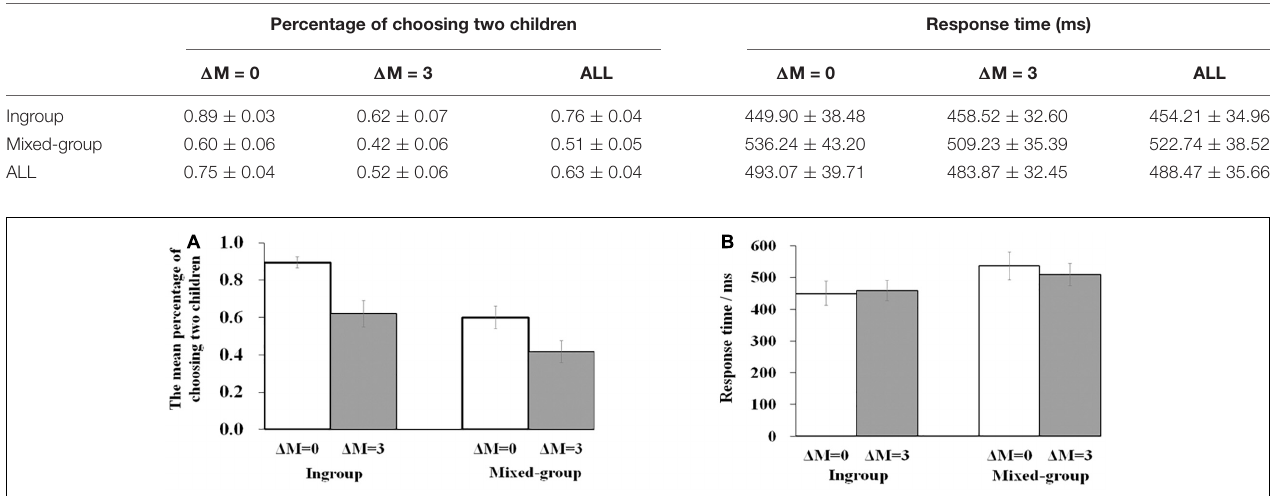
TABLE 1 | Summary of behavior results on percentage of relatively equity decisions and response time (M ± SE). Percentage of choosing two children